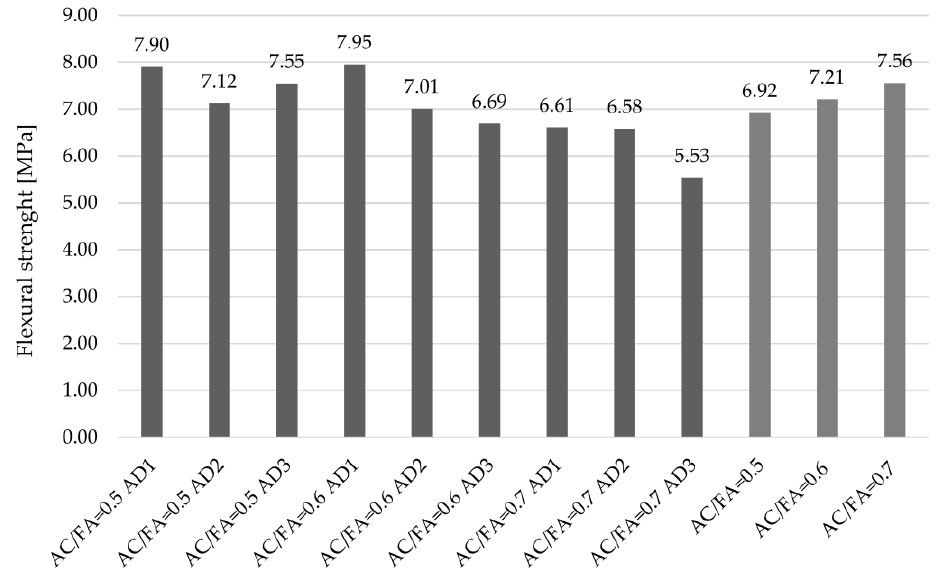
Figure 1. Flexural strength results for all series.